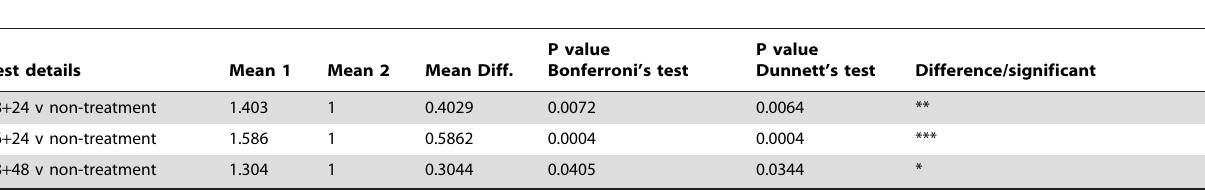
Table 4. Statistical comparisons (ANOVA) for Hsp70 protein levels in flies treated with combinations of 17 DMAG and dexamethasone.